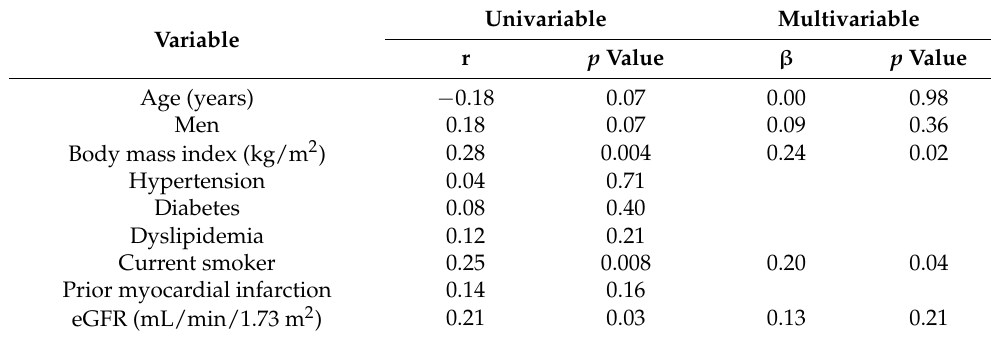
Table 3. Factors associated with the log-transformed XOR